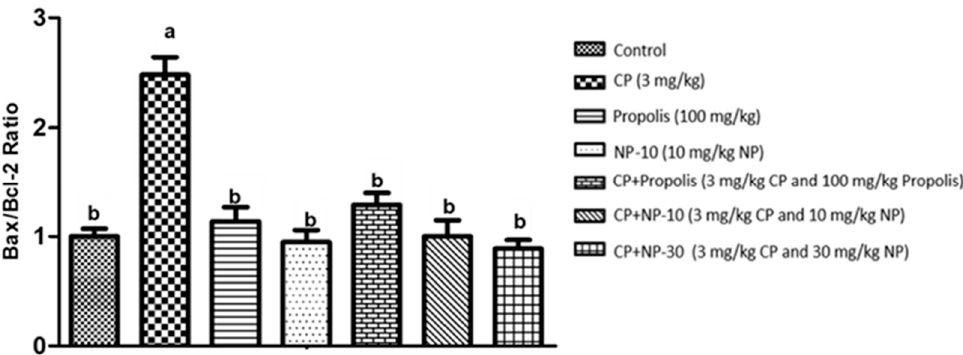
Figure 6. Bax / Bcl-2 protein expression ratio in kidney tissue. a,b,c: Mean values within a row di ff er Figure 6. Bax/Bcl-2 protein expression ratio in kidney tissue. a,b,c: Mean values within a row differ significantly, Significance is p < 0.001 (CP: cisplatin; NP: significantly, Significance is p < 0.001 (CP: cisplatin; NP: nano-propolis). Figure 6. Bax/Bcl-2 protein expression ratio in kidney tissue. a,b,c: Mean values within a row differ Figure 6. Bax/Bcl-2 protein expression ratio in kidney tissue. a,b,c: Mean values within a row differ significantly, Significance is p < 0.001 (CP: cisplatin; NP: nano-propolis). significantly, Significance is p < 0.001 (CP: cisplatin; NP: nano-propolis).